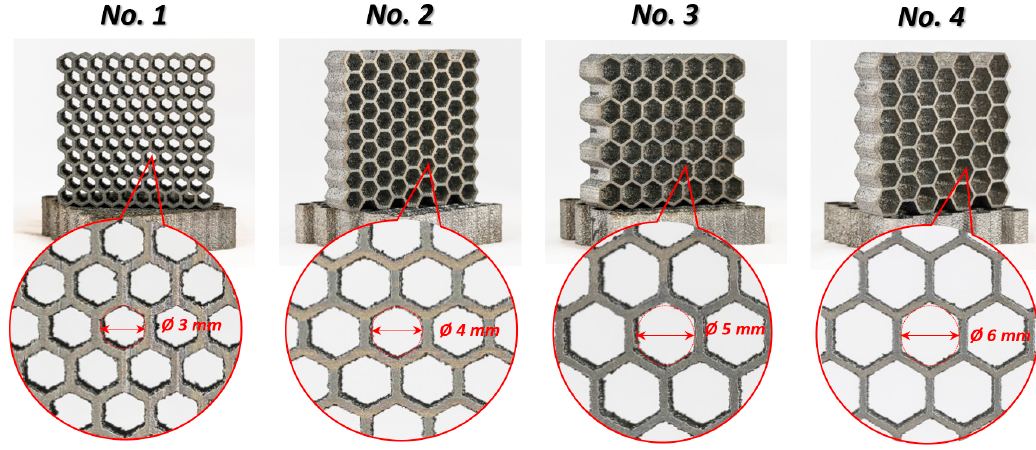
Figure 4. Four variants of Ti6Al4V thin-walled honeycomb structures with different the cell size (No. 1–No. 4) manufactured by the laser engineered net shaping (LENS TM ) technique.